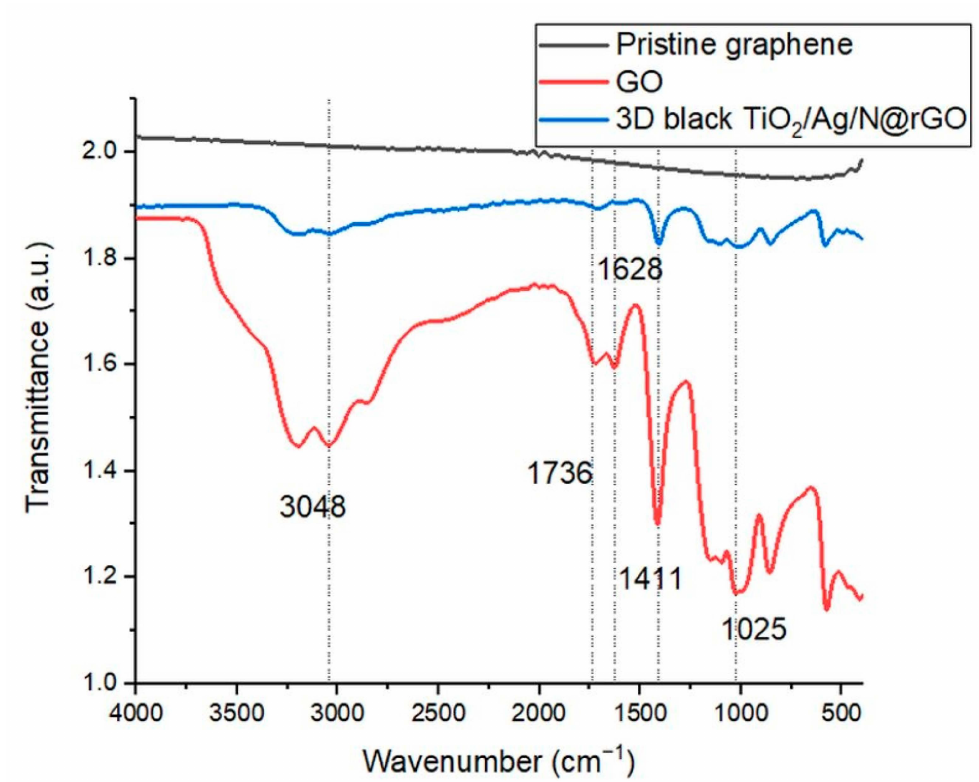
Figure 7. FTIR spectra of graphene oxide (GO, red), reduced graphene oxide (rGO, blue), and pristine graphene